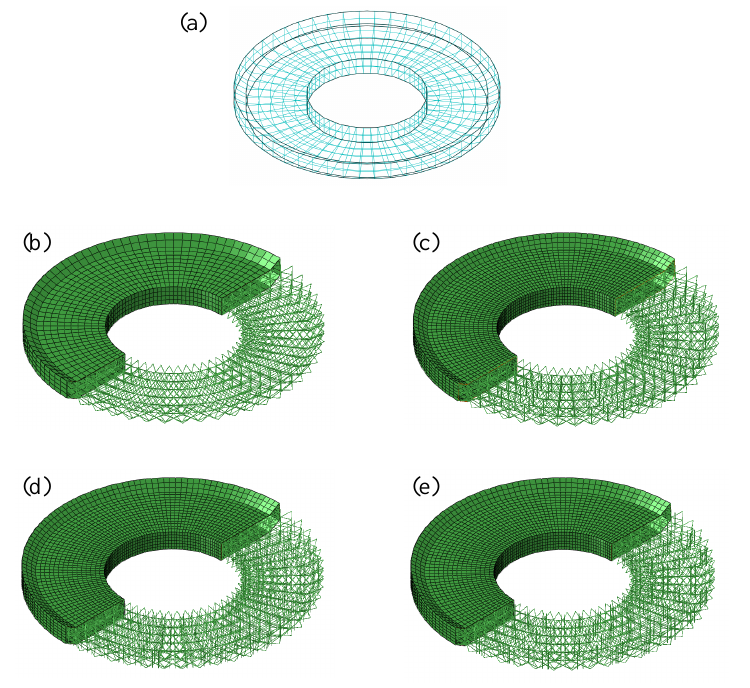
Figure 13. Spatial grids and lattice structure of the four designs. ( a ) Spatial grids; ( b ) D-BCC;